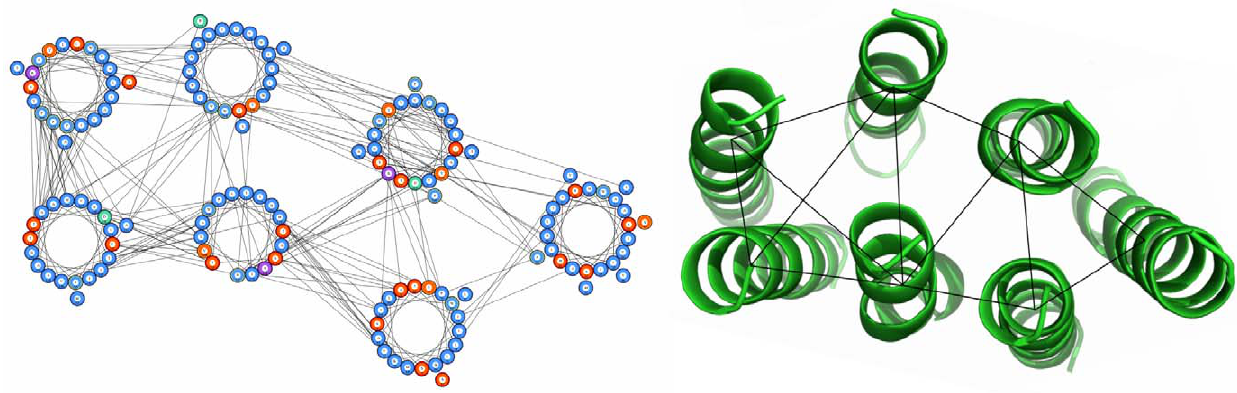
Figure 1. Predicted helical packing arrangement and crystal structure of Halorhodopsin (1E12:A). In this example the two left-most helices share the same interactions. The correct arrangement has been identified as having no same-side loop crossovers, compared to one for the incorrect arrangement. Predicted residue-residue contacts are annotated on the packing arrangement while observed helix-helix interactions are annotated on the crystal